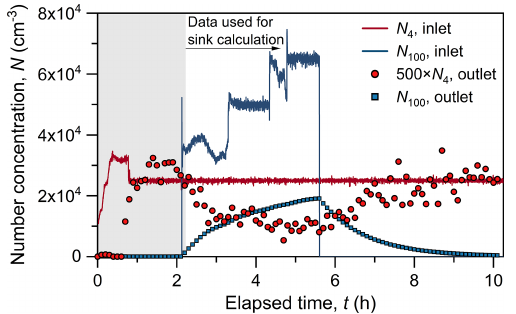
Figure 2. Time series of particle number concentrations measured at the inlets and outlets of the chamber during an experimental run. The inlet particle concentrations ( N ) were controlled using mass flow controllers. Assuming perfect mixing in the chamber, particle concentrations in the chamber are equal to the outlet concentrations. The subscript of N indicates particle size innm. Due to the long residence time ( ∼ 1h) of 100nm particles, the outlet N 100 changed slowly towards its steady-state concentration when the inlet N 100 was kept stable.